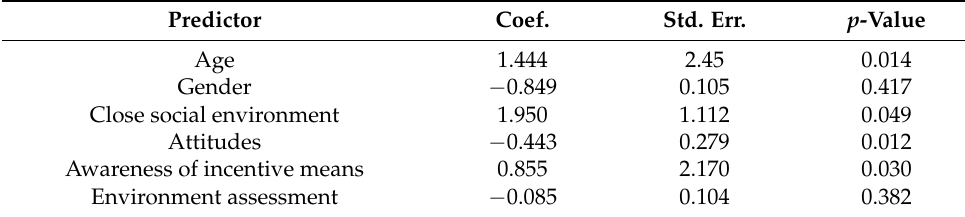
Table 8. Key result parameters of the ARIMA regression.